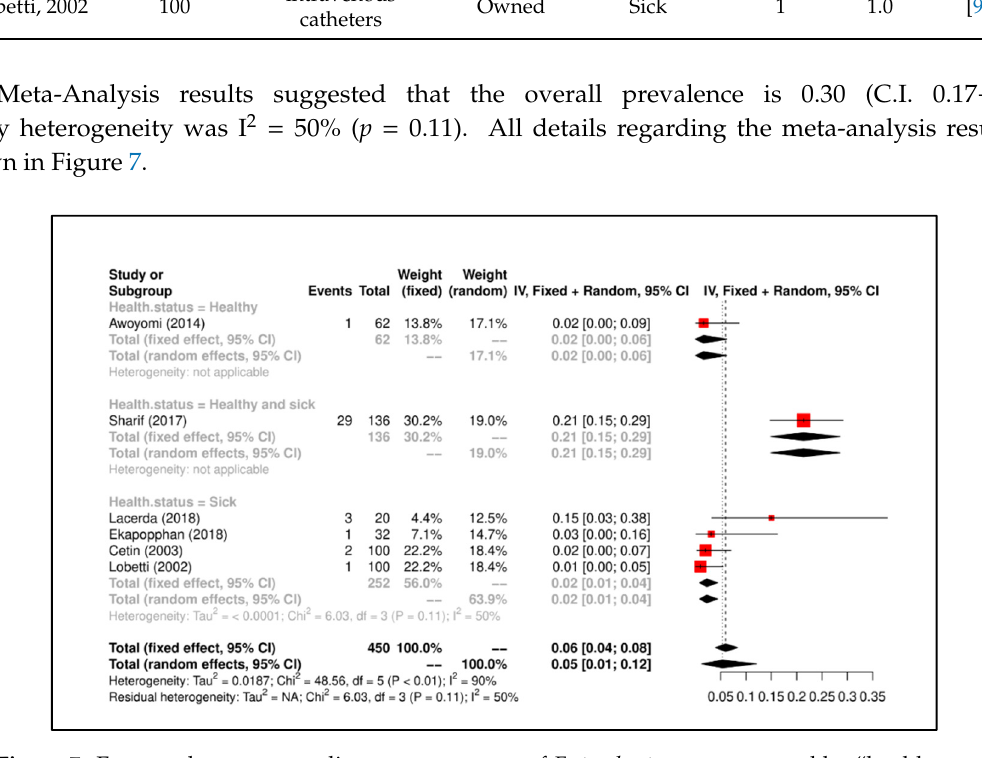
Figure 7. Forrest plot corresponding to occurrences of Enterobacter spp. grouped by “health status of dog”.